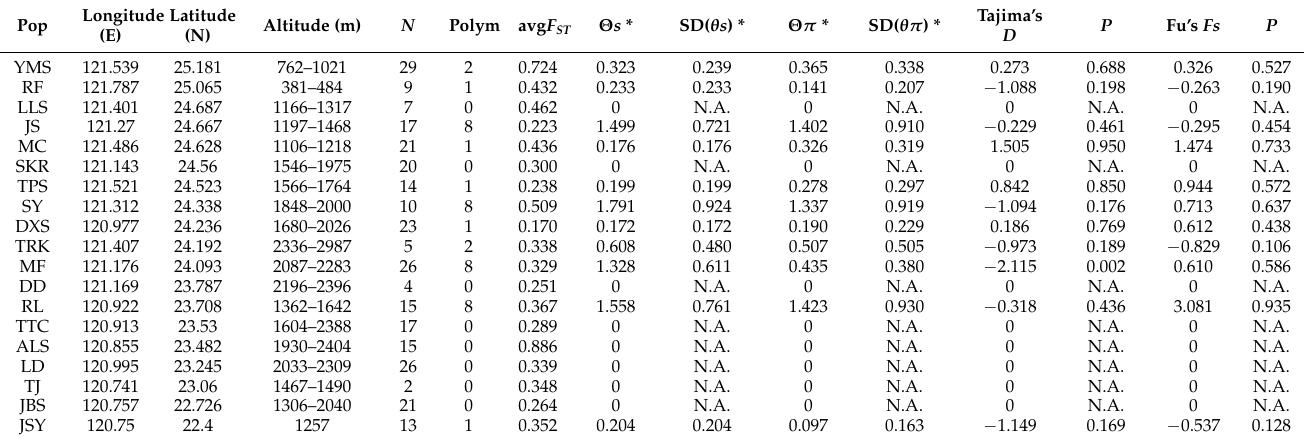
Table 1. Sampling site information and summary statistics of genetic